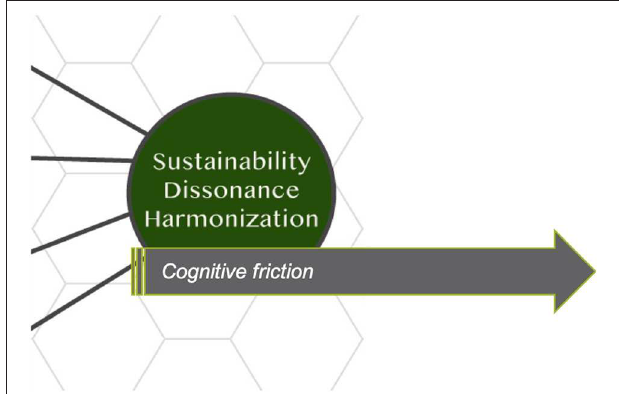
FIGURE 4 | From harmonization to friction,